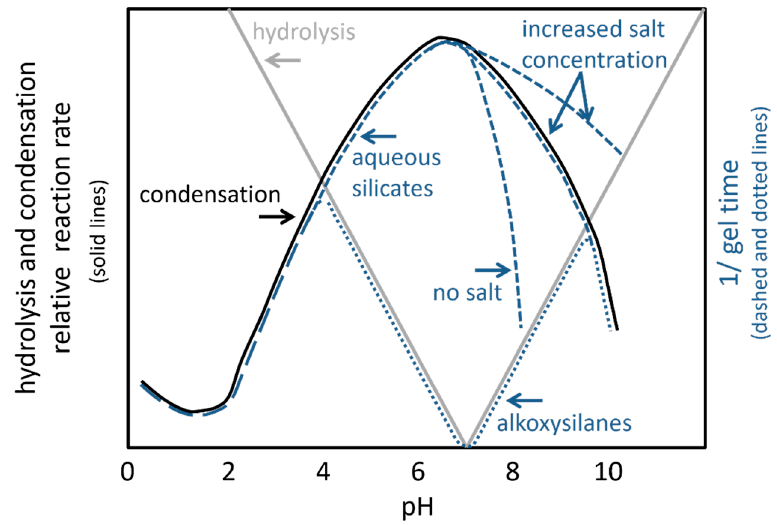
Figure 4. Schematic representation of hydrolysis and condensation rate as well as gel time in dependence of the pH; from [58,64,72,73].